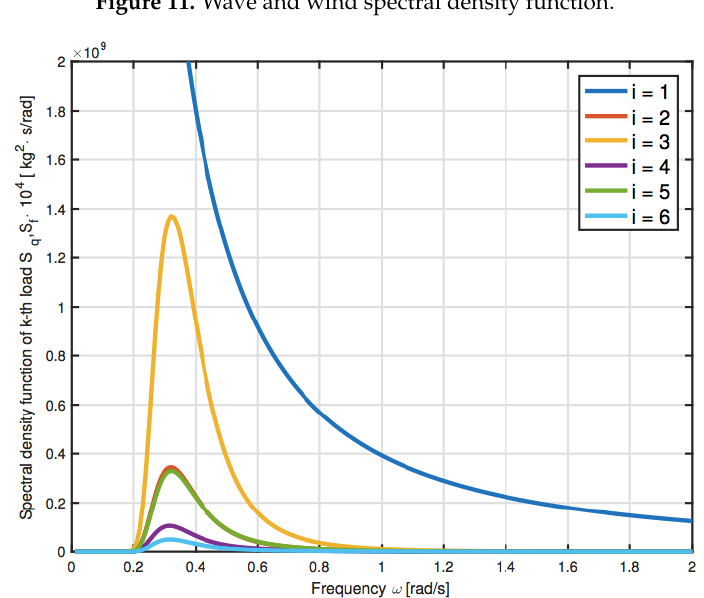
Figure 12. Spectral density of the generic environmental load in modal coordinates of the 6DOF